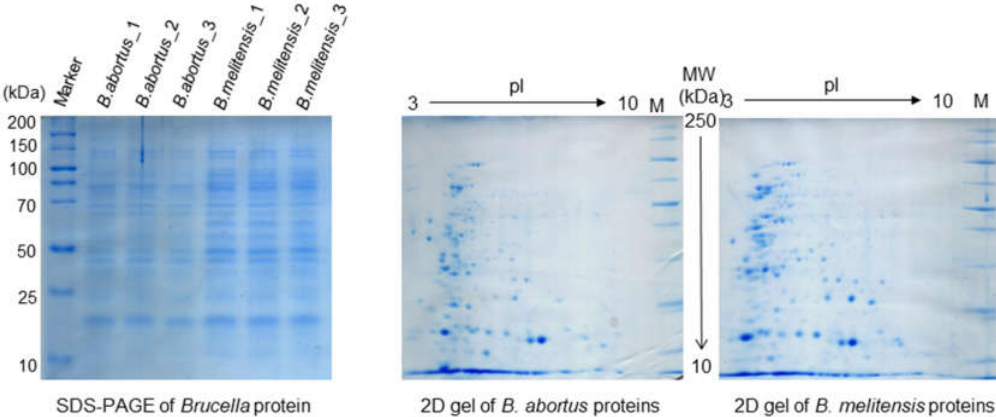
Figure 1. SDS-PAGE and two-dimensional gel electrophoresis (2DE)-stained gel with Coomassie